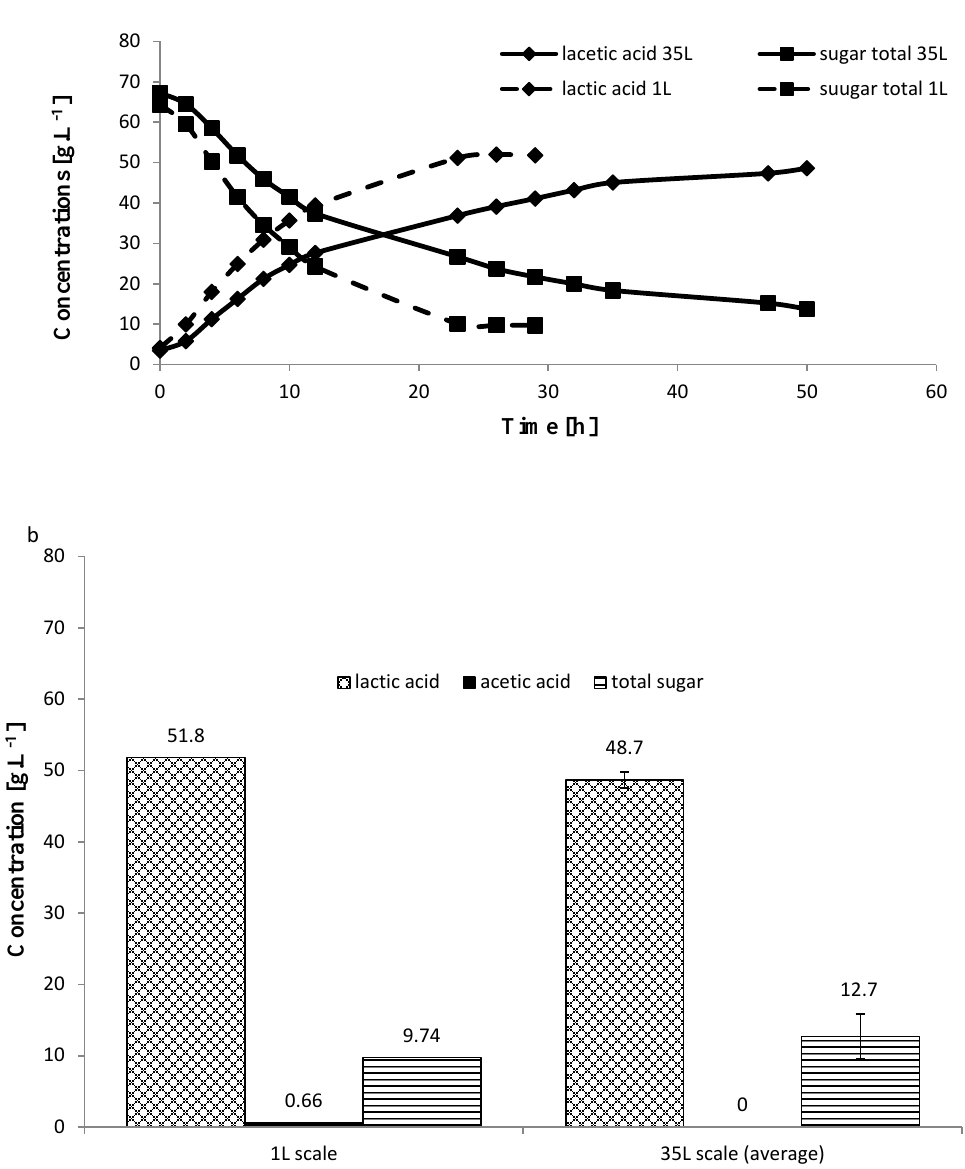
Figure 5. Lactic acid production and remaining sugars trend during fermentation after sugar hydrolysis followed by protein hydrolysis of carob biomass (30% DM) conducted in one liter fermenter compared to 35 L pilot scale without yeast extract using isolate A107 ( a ) and comparison end of total lactic acid, acetic acid, and total sugars after fermentation without yeast extract ( b ). Each data point represents the mean of 2 replicates ± SD of the pilot scale and one replicate for the 1L scale.